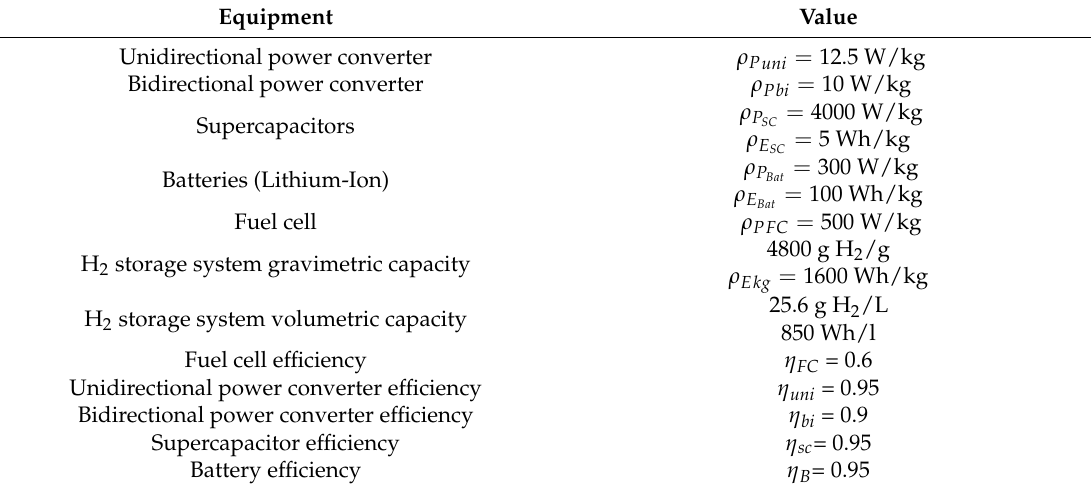
Table 1. Subsystems architectures data [29].